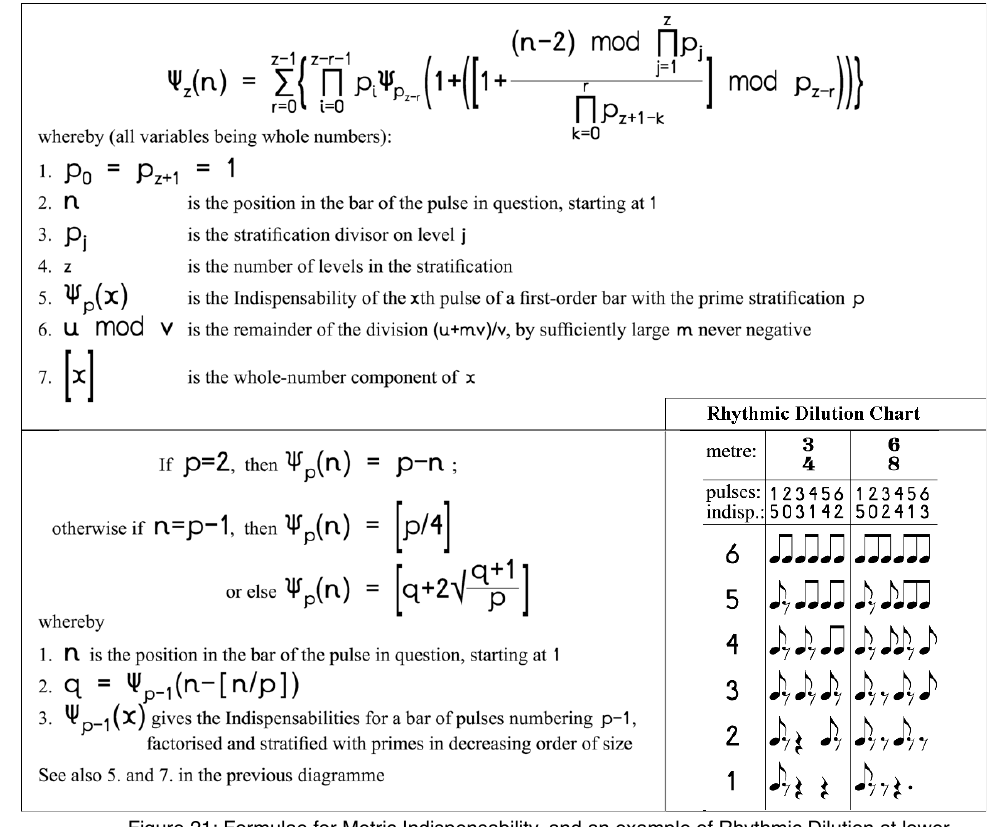
Figure 21: Formulae for Metric Indispensability, and an example of Rhythmic Dilution at lower